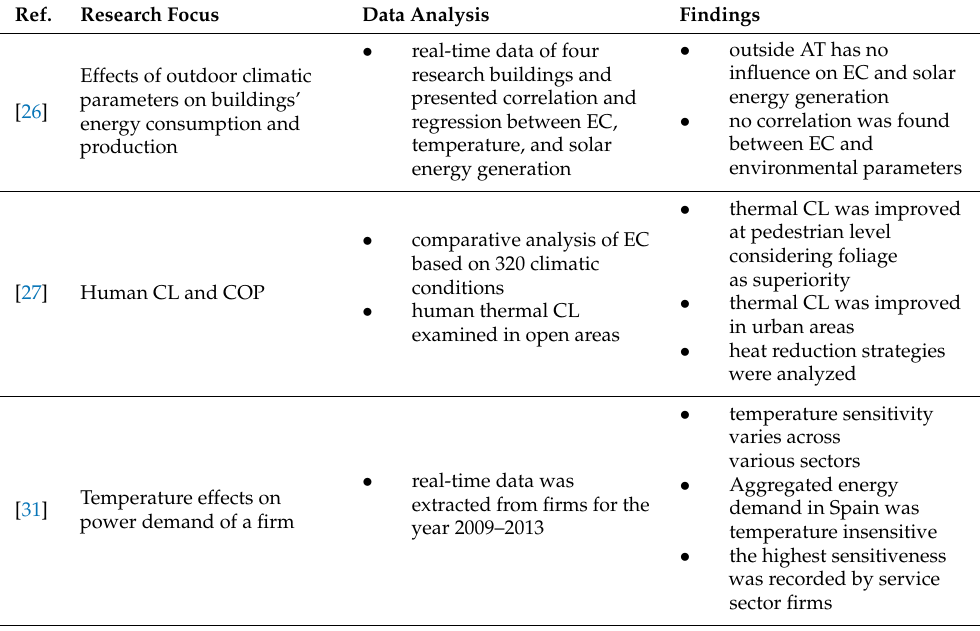
needs to be increased due to global warming. Table 1. State-of-the-art works on mutual interactions of energy consumption, comfort level, and Table 1. State-of-the-art works on mutual interactions of energy consumption, comfort level, and Table 1. State-of-the-art works on mutual interactions of energy consumption, comfort level, and Table 1. State-of-the-art works on mutual interactions of energy consumption, comfort level, and Table 1. State-of-the-art works on mutual interactions of energy consumption, comfort level, and Table 1. State-of-the-art works on mutual interactions of energy consumption, comfort level, and Table 1. State-of-the-art works on mutual interactions of energy consumption, comfort level, and environmental parametric variations. Table 1. State-of-the-art works on mutual interactions of energy consumption, comfort level, and environmental parametric variations. environmental parametric variations. environmental parametric variations. environmental parametric variations. environmental parametric variations. environmental parametric variations. environmental parametric variations. Table 1. State-of-the-art works on mutual interactions of energy consumption, comfort level, and Table 1. State-of-the-art works on mutual interactions of energy consumption, comfort level, and Table 1. State-of-the-art works on mutual interactions of energy consumption, comfort level, and environmental parametric variations. environmental parametric variations. environmental parametric variations. Table 1. State-of-the-art works on mutual interactions of energy consumption, comfort level, and Table 1. State-of-the-art works on mutual interactions of energy consumption, comfort level, and Table 1. State-of-the-art works on mutual interactions of energy consumption, comfort level, and Table 1. State-of-the-art works on mutual interactions of energy consumption, comfort level, and Table 1. State-of-the-art works on mutual interactions of energy consumption, comfort level, and Table 1. State-of-the-art works on mutual interactions of energy consumption, comfort level, and environmental parametric variations. environmental parametric variations. environmental parametric variations. environmental parametric variations. environmental parametric variations. environmental parametric variations. Table 1. State-of-the-art works on mutual interactions of energy consumption, comfort level, and Table 1. State-of-the-art works on mutual interactions of energy consumption, comfort level, and Table 1. State-of-the-art works on mutual interactions of energy consumption, comfort level, and Table 1. State-of-the-art works on mutual interactions of energy consumption, comfort level, and environmental parametric variations. environmental parametric variations. environmental parametric variations. environmental parametric variations. Table 1. State-of-the-art works on mutual interactions of energy consumption, comfort level, and Table 1. State-of-the-art works on mutual interactions of energy consumption, comfort level, and Table 1. State-of-the-art works on mutual interactions of energy consumption, comfort level, and Table 1. State-of-the-art works on mutual interactions of energy consumption, comfort level, and Table 1. State-of-the-art works on mutual interactions of energy consumption, comfort level, and Table 1. State-of-the-art works on mutual interactions of energy consumption, comfort level, and Table 1. State-of-the-art works on mutual interactions of energy consumption, comfort level, and Table 1. State-of-the-art works on mutual interactions of energy consumption, comfort level, and Table 1. State-of-the-art works on mutual interactions of energy consumption, comfort level, and environmental parametric variations. environmental parametric variations. environmental parametric variations. environmental parametric variations. environmental parametric variations. environmental parametric variations. environmental parametric variations. environmental parametric variations. environmental parametric variations. Table 1. State-of-the-art works on mutual interactions of energy consumption, comfort level, and Table 1. State-of-the-art works on mutual interactions of energy consumption, comfort level, and Table 1. State-of-the-art works on mutual interactions of energy consumption, comfort level, and Table 1. State-of-the-art works on mutual interactions of energy consumption, comfort level, and Table 1. State-of-the-art works on mutual interactions of energy consumption, comfort level, and Table 1. State-of-the-art works on mutual interactions of energy consumption, comfort level, and Table 1. State-of-the-art works on mutual interactions of energy consumption, comfort level, and Table 1. State-of-the-art works on mutual interactions of energy consumption, comfort level, and Table 1. State-of-the-art works on mutual interactions of energy consumption, comfort level, and environmental parametric variations. environmental parametric variations. environmental parametric variations. environmental parametric variations. environmental parametric variations. environmental parametric variations. environmental parametric variations. environmental parametric variations. environmental parametric variations. Table 1. State-of-the-art works on mutual interactions of energy consumption, comfort level, and Table 1. State-of-the-art works on mutual interactions of energy consumption, comfort level, and Table 1. State-of-the-art works on mutual interactions of energy consumption, comfort level, and Table 1. State-of-the-art works on mutual interactions of energy consumption, comfort level, and Table 1. State-of-the-art works on mutual interactions of energy consumption, comfort level, and Table 1. State-of-the-art works on mutual interactions of energy consumption, comfort level, and Table 1. State-of-the-art works on mutual interactions of energy consumption, comfort level, and Table 1. State-of-the-art works on mutual interactions of energy consumption, comfort level, and Table 1. State-of-the-art works on mutual interactions of energy consumption, comfort level, and Ref. environmental parametric variations. environmental parametric variations. environmental parametric variations. environmental parametric variations. environmental parametric variations. environmental parametric variations. environmental parametric variations. environmental parametric variations. environmental parametric variations. Table 1. State-of-the-art works on mutual interactions of energy consumption, comfort level, and Table 1. State-of-the-art works on mutual interactions of energy consumption, comfort level, and Table 1. State-of-the-art works on mutual interactions of energy consumption, comfort level, and Table 1. State-of-the-art works on mutual interactions of energy consumption, comfort level, and Table 1. State-of-the-art works on mutual interactions of energy consumption, comfort level, and Table 1. State-of-the-art works on mutual interactions of energy consumption, comfort level, and environmental parametric variations. environmental parametric variations. environmental parametric variations. environmental parametric variations. environmental parametric variations. environmental parametric variations. Table 1. State-of-the-art works on mutual interactions of energy consumption, comfort level, and Table 1. State-of-the-art works on mutual interactions of energy consumption, comfort level, and Table 1. State-of-the-art works on mutual interactions of energy consumption, comfort level, and Table 1. State-of-the-art works on mutual interactions of energy consumption, comfort level, and Ref. environmental parametric variations. environmental parametric variations. environmental parametric variations. Table 1. State-of-the-art works on mutual interactions of energy consumption, comfort level, and Table 1. State-of-the-art works on mutual interactions of energy consumption, comfort level, and Table 1. State-of-the-art works on mutual interactions of energy consumption, comfort level, and Table 1. State-of-the-art works on mutual interactions of energy consumption, comfort level, and Table 1. State-of-the-art works on mutual interactions of energy consumption, comfort level, and environmental parametric variations. environmental parametric variations. environmental parametric variations. environmental parametric variations. environmental parametric variations. Table 1. State-of-the-art works on mutual interactions of energy consumption, comfort level, and Table 1. State-of-the-art works on mutual interactions of energy consumption, comfort level, and Table 1. State-of-the-art works on mutual interactions of energy consumption, comfort level, and Table 1. State-of-the-art works on mutual interactions of energy consumption, comfort level, and Ref. environmental parametric variations. environmental parametric variations. environmental parametric variations. environmental parametric variations. Table 1. State-of-the-art works on mutual interactions of energy consumption, comfort level, and Table 1. State-of-the-art works on mutual interactions of energy consumption, comfort level, and Table 1. State-of-the-art works on mutual interactions of energy consumption, comfort level, and Table 1. State-of-the-art works on mutual interactions of energy consumption, comfort level, and Table 1. State-of-the-art works on mutual interactions of energy consumption, comfort level, and Table 1. State-of-the-art works on mutual interactions of energy consumption, comfort level, and Table 1. State-of-the-art works on mutual interactions of energy consumption, comfort level, and Table 1. State-of-the-art works on mutual interactions of energy consumption, comfort level, and Ref. environmental parametric variations. environmental parametric variations. environmental parametric variations. environmental parametric variations. environmental parametric variations. environmental parametric variations. environmental parametric variations. environmental parametric variations. Table 1. State-of-the-art works on mutual interactions of energy consumption, comfort level, and Table 1. State-of-the-art works on mutual interactions of energy consumption, comfort level, and Table 1. State-of-the-art works on mutual interactions of energy consumption, comfort level, and Table 1. State-of-the-art works on mutual interactions of energy consumption, comfort level, and Table 1. State-of-the-art works on mutual interactions of energy consumption, comfort level, and environmental parametric variations. environmental parametric variations. environmental parametric variations. environmental parametric variations. Table 1. State-of-the-art works on mutual interactions of energy consumption, comfort level, and Table 1. State-of-the-art works on mutual interactions of energy consumption, comfort level, and Table 1. State-of-the-art works on mutual interactions of energy consumption, comfort level, and Table 1. State-of-the-art works on mutual interactions of energy consumption, comfort level, and Table 1. State-of-the-art works on mutual interactions of energy consumption, comfort level, and Table 1. State-of-the-art works on mutual interactions of energy consumption, comfort level, and Ref. Ref. environmental parametric variations. environmental parametric variations. environmental parametric variations. environmental parametric variations. environmental parametric variations. environmental parametric variations. Table 1. State-of-the-art works on mutual interactions of energy consumption, comfort level, and Table 1. State-of-the-art works on mutual interactions of energy consumption, comfort level, and Table 1. State-of-the-art works on mutual interactions of energy consumption, comfort level, and Table 1. State-of-the-art works on mutual interactions of energy consumption, comfort level, and Table 1. State-of-the-art works on mutual interactions of energy consumption, comfort level, and Table 1. State-of-the-art works on mutual interactions of energy consumption, comfort level, and Ref. Ref. environmental parametric variations. environmental parametric variations. environmental parametric variations. environmental parametric variations. environmental parametric variations. environmental parametric variations. Table 1. State-of-the-art works on mutual interactions of energy consumption, comfort level, and Table 1. State-of-the-art works on mutual interactions of energy consumption, comfort level, and Table 1. State-of-the-art works on mutual interactions of energy consumption, comfort level, and Table 1. State-of-the-art works on mutual interactions of energy consumption, comfort level, and Table 1. State-of-the-art works on mutual interactions of energy consumption, comfort level, and Table 1. State-of-the-art works on mutual interactions of energy consumption, comfort level, and Table 1. State-of-the-art works on mutual interactions of energy consumption, comfort level, and Table 1. State-of-the-art works on mutual interactions of energy consumption, comfort level, and Table 1. State-of-the-art works on mutual interactions of energy consumption, comfort level, and Ref. Ref. environmental parametric variations. environmental parametric variations. environmental parametric variations. environmental parametric variations. environmental parametric variations. environmental parametric variations. environmental parametric variations. environmental parametric variations. environmental parametric variations. Table 1. State-of-the-art works on mutual interactions of energy consumption, comfort level, and Table 1. State-of-the-art works on mutual interactions of energy consumption, comfort level, and Table 1. State-of-the-art works on mutual interactions of energy consumption, comfort level, and Table 1. State-of-the-art works on mutual interactions of energy consumption, comfort level, and Table 1. State-of-the-art works on mutual interactions of energy consumption, comfort level, and Table 1. State-of-the-art works on mutual interactions of energy consumption, comfort level, and Table 1. State-of-the-art works on mutual interactions of energy consumption, comfort level, and Table 1. State-of-the-art works on mutual interactions of energy consumption, comfort level, and Table 1. State-of-the-art works on mutual interactions of energy consumption, comfort level, and environmental parametric variations. environmental parametric variations. environmental parametric variations. environmental parametric variations. environmental parametric variations. environmental parametric variations. environmental parametric variations. environmental parametric variations. Table 1. State-of-the-art works on mutual interactions of energy consumption, comfort level, and Table 1. State-of-the-art works on mutual interactions of energy consumption, comfort level, and Table 1. State-of-the-art works on mutual interactions of energy consumption, comfort level, and Table 1. State-of-the-art works on mutual interactions of energy consumption, comfort level, and Table 1. State-of-the-art works on mutual interactions of energy consumption, comfort level, and Table 1. State-of-the-art works on mutual interactions of energy consumption, comfort level, and Table 1. State-of-the-art works on mutual interactions of energy consumption, comfort level, and Table 1. State-of-the-art works on mutual interactions of energy consumption, comfort level, and Ref. environmental parametric variations. environmental parametric variations. environmental parametric variations. environmental parametric variations. environmental parametric variations. environmental parametric variations. environmental parametric variations. environmental parametric variations. Table 1. State-of-the-art works on mutual interactions of energy consumption, comfort level, and Table 1. State-of-the-art works on mutual interactions of energy consumption, comfort level, and Table 1. State-of-the-art works on mutual interactions of energy consumption, comfort level, and Table 1. State-of-the-art works on mutual interactions of energy consumption, comfort level, and Table 1. State-of-the-art works on mutual interactions of energy consumption, comfort level, and Table 1. State-of-the-art works on mutual interactions of energy consumption, comfort level, and Table 1. State-of-the-art works on mutual interactions of energy consumption, comfort level, and Ref. Ref. environmental parametric variations. environmental parametric variations. environmental parametric variations. environmental parametric variations. environmental parametric variations. environmental parametric variations. Ref. Ref. Ref.